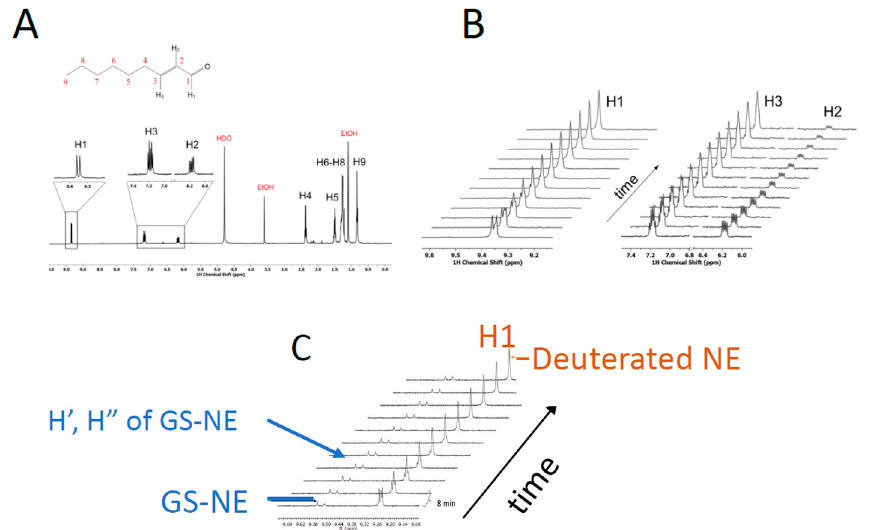
Figure 4. Chemical Structure and 1 H-NMR spectrum of NE. ( A ) The structure of NE is shown with carbons or corresponding protons numbered. The 1 H-NMR spectrum of NE is shown below its chemical structure. The H1, H2, and H3 protons provide probes of the D 2 O exchange at carbon 2, or C2. ( B ) Time-dependent changes in H1, H2, H3 upon incubation with GSTA4-4 in the presence of GSH. ( C ) Time-dependent exchange of 1 H of NE to yield deuterated substrate without change in [GS-NE] after the dead time of 4–5 min. The protons H ′ and H ″ are from GS-NE formed at low concentrations due to limiting [GSH]. For ( B , C ), the arrows show the time dependence of the spectra.